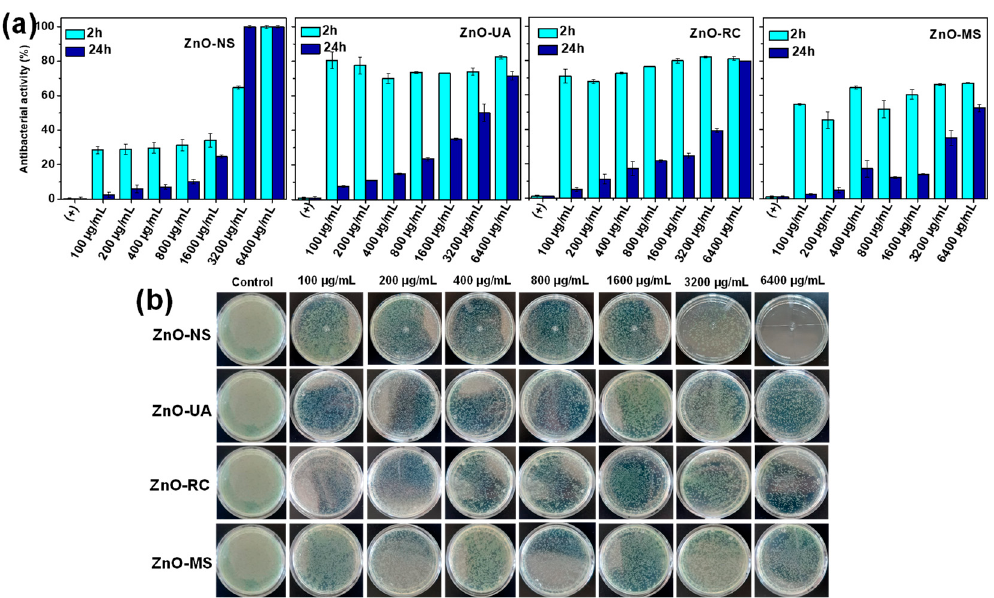
Figure 8. ( a ) Antibacterial activity test of ZnO nanoparticles obtained from Sargassum ssp. at different experimental conditions. ( b ) Representative photographs of plates obtained from the interaction of ZnO nanoparticles after 2 h of contact against Gram-negative P. aeruginosa .